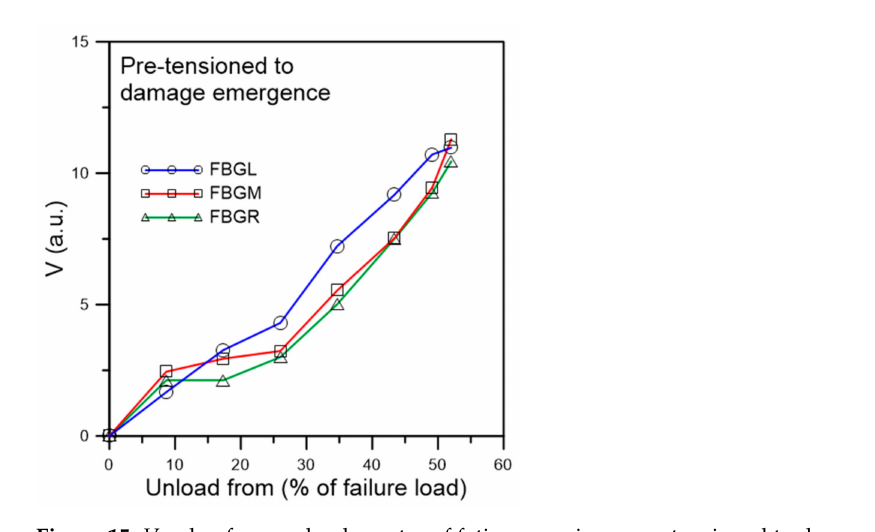
Figure 14. Unload spectra of fatigue specimen pre-tensioned to damage emergence.